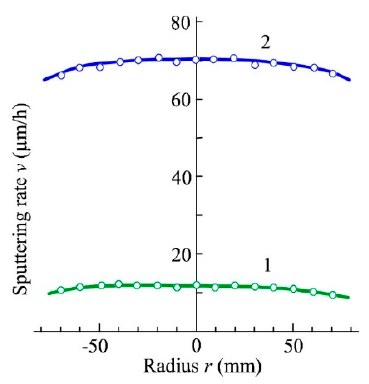
Figure 5. The radial distribution of the target surface sputtering rate. 1—the argon pressure p = 0.4 Pa, the voltage between the hollow cathode and the target U t = 0, the discharge current in the anode circuit I d = 1.8 A. 2—the voltage U t = 2 kV, the current I d = 1.8 A.